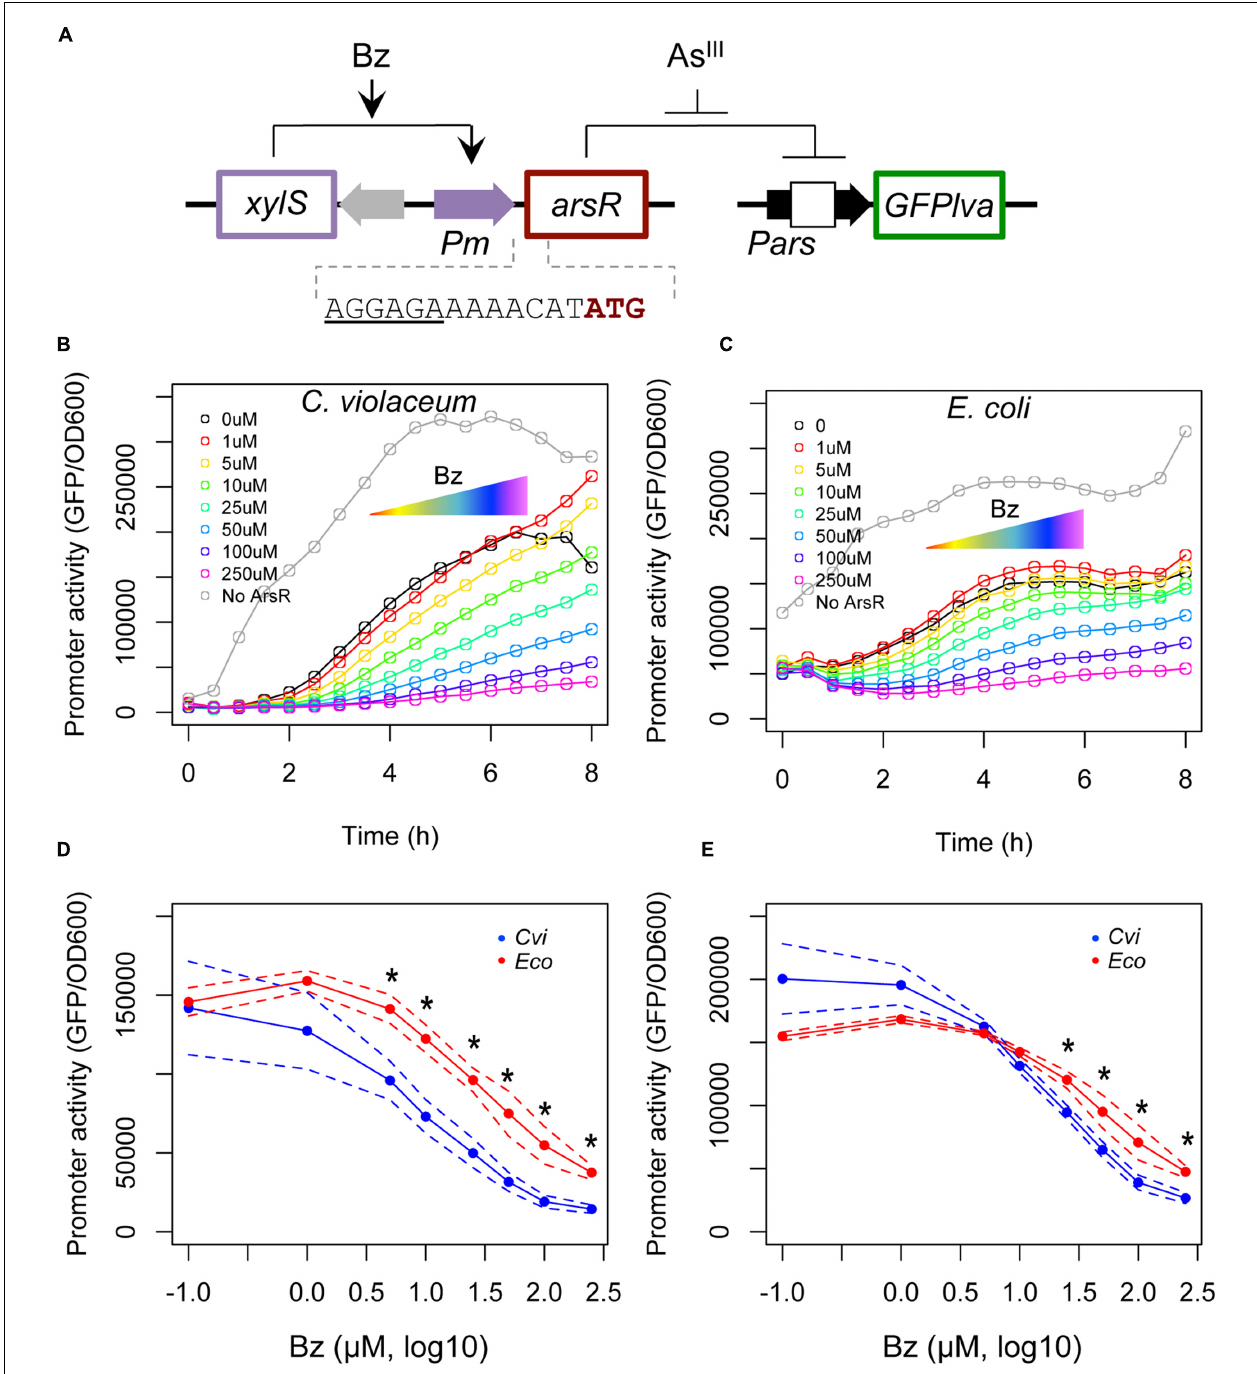
FIGURE 3 | In vivo titration experiments using a benzoate inducible system. (A) Schematic representation of the circuit used. In this system, the target regulator is placed under the control of the XylS/ Pm expression cassette from pSEVA438 (Silva-Rocha et al., 2013b). To ensure similar levels of ArsR regulators were produced, a strong RBS element was introduced between the Pm promoter and the start codon of the gene. A second plasmid based on pRV2 was used where expression of a GFPlva reporter gene is placed under the control of the target promoter. Promoter activities were assayed during the growth curve analysis using increasing concentrations of benzoate (Bz, from 0 to 250 µ M). (B) In vivo titration of ArsR/ Pars from C. violaceum . (C) In vivo titration of ArsR/ Pars from E. coli . Gray lines represent control strains harboring the empty pSEVA438 vector (i.e., no ArsR production). (D,E) Repression kinetics of Pars cvi (blue) and Pars eco (red) upon exposure to increasing benzoate concentrations after four (D) or six (E) hours of induction. Solid lines represent the average of three independent experiments, whereas dashed lines represents the upper and lower limits of standard deviations. Statistics differences are highlighted by ( ∗ ) as analyzed using Student’s t -test with p -value p <